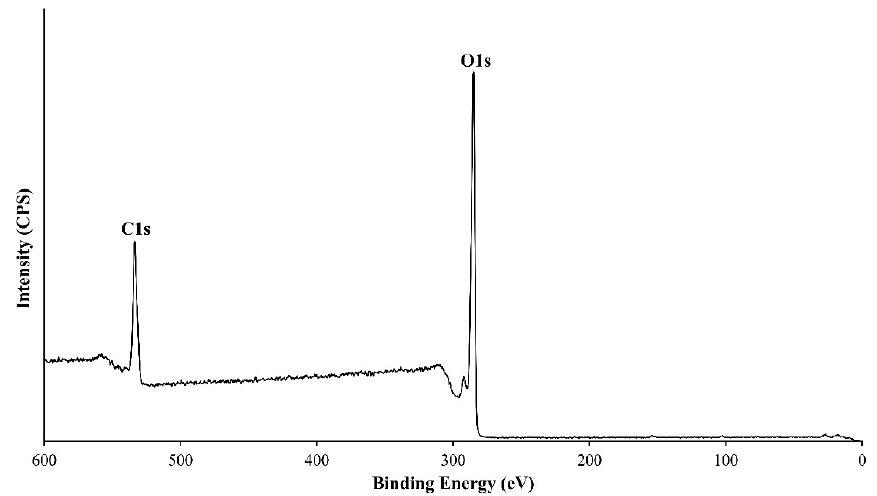
Figure 3. XPS survey scan (0–600 eV) for as-received PEEK.